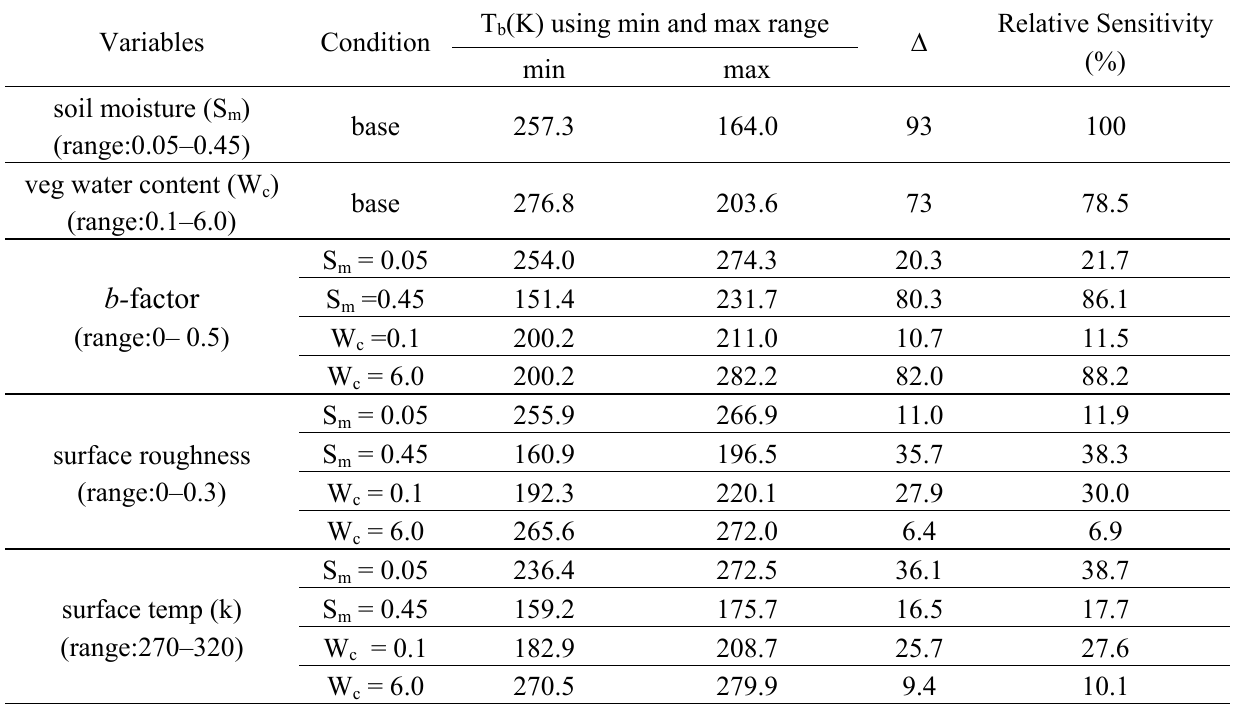
Table 2. Relative sensitivity of variable to four conditions (1) Dry and wet soil moisture condition, (2) Low and high vegetated field conditions.